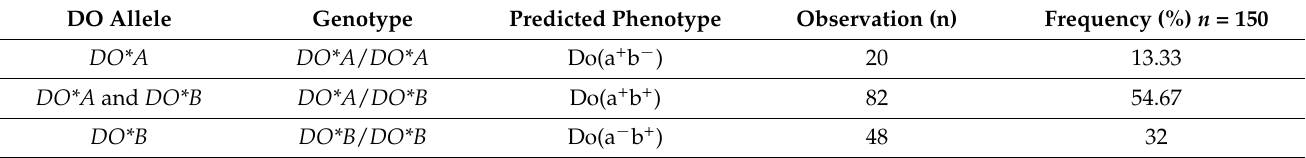
Table 3. The frequencies of the DO genotypes and their predicted phenotypes in a population of Saudi blood donors from the Jazan